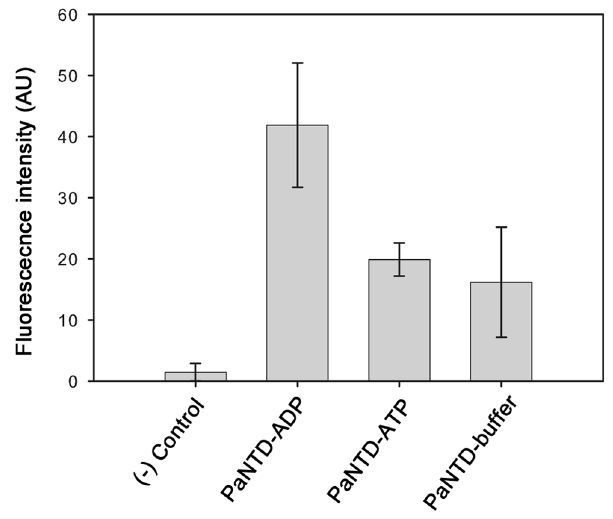
Figure 9. Analysis of PaNTD-PaCTD interaction using far Western assays. Purified PaCTD (6.5 pmol) and BSA (20 pmol) with no Histag were spotted onto nitrocellulose membranes. The mem- branes were incubated with His6-PaNTD (0.6 m M) with buffer B, buffer plus ADP 0.1 mM or ATP 0.1 mM followed by immunochemical detection of His6-PaNTD as described in Material and methods. The fluorescence intensity was measured using imageJ. Error bars represent the standard deviation from triplicate experiments. AU: Arbitrary